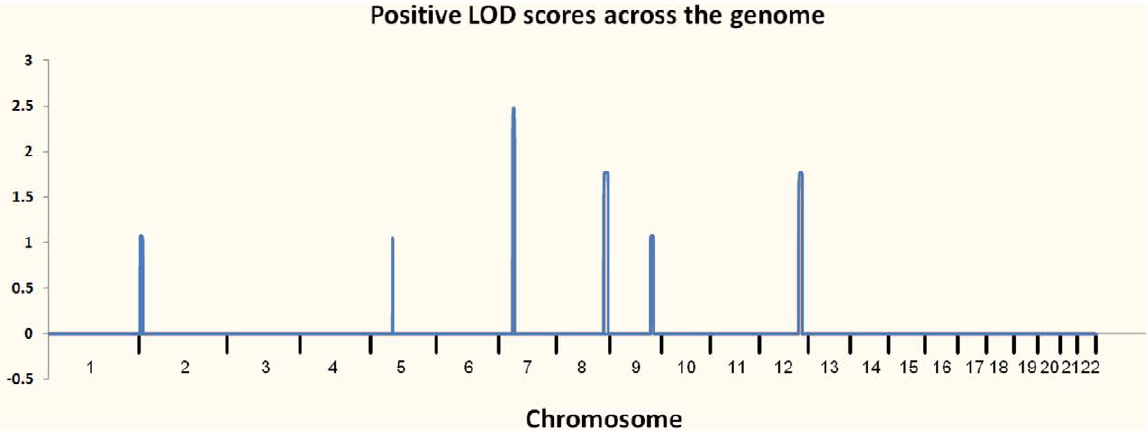
Figure 3. Plot of linkage results from Pedigree 1. The regions investigated for causal variants were 7p14.1, 8q24.1, 12q23, 2p25, 5q12.1, and